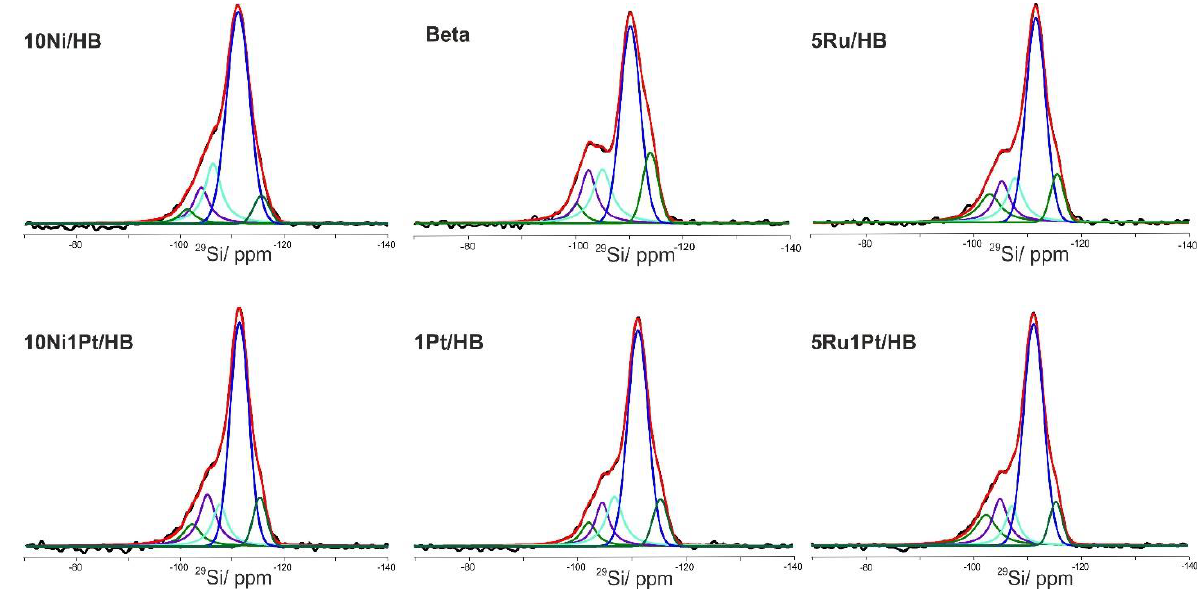
Figure 5. Experimental (black) and simulated (red) single-pulse 29 Si NMR spectra of the studied zeolites. The individual contributions of the different Si environments are given with colored lines. Table 2. Area of the signals of the different Si structural units, obtained by deconvolution of the spectral patterns in the